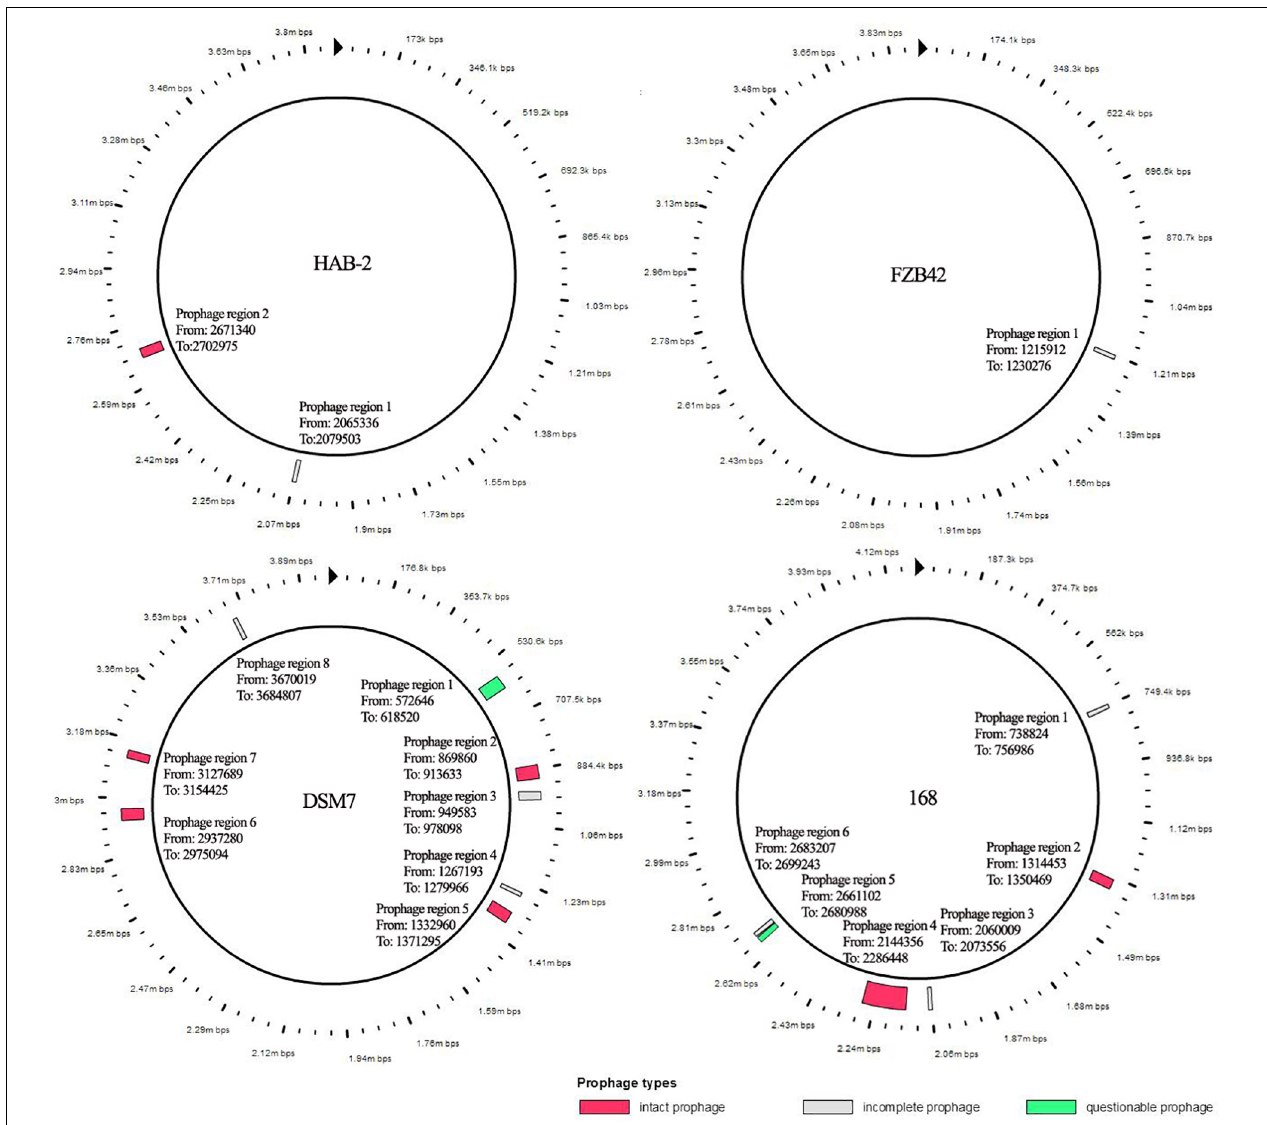
FIGURE 2 | Prophage of B. velezensis HAB-2 and comparison with other Bacillus spp. All prophage regions in different colors code according to completeness, a prediction of whether the region contains an intact or incomplete prophage. If the region’s total score is < 70, it is marked as incomplete (gray); if within 70–90, it is marked as questionable (green); if > 90, it is marked as intact (red). HAB-2: two prophage regions identified, of which one is intact (Pr 2, with 46 CDS) and one is incomplete (Pr 1, 12 CDS). Bacillus velezensis FZB42: one prophage region identified, which is incomplete (Pr 1, 25 CDS). Bacillus amyloliquefaciens DSM7: eight prophage regions identified, of which four are intact (Pr2, 46 CDS; Pr 5, 49 CDS; Pr 6, 27 CDS; and Pr 7, 29 CDS), three are incomplete (Pr 3, 24 CDS; Pr 4, 18 CDS; and Pr 8, 17 CDS) and one is questionable (Pr 1, 63 CDS). Bacillus subtilis 168: six prophage regions identified, of which two are intact (Pr 2, 49 CDS and Pr 4, 198 CDS), three are incomplete (Pr 1, 20 CDS; Pr 3, 13 CDS; and Pr 6, 23 CDS) and one is questionable (Pr 5, 21